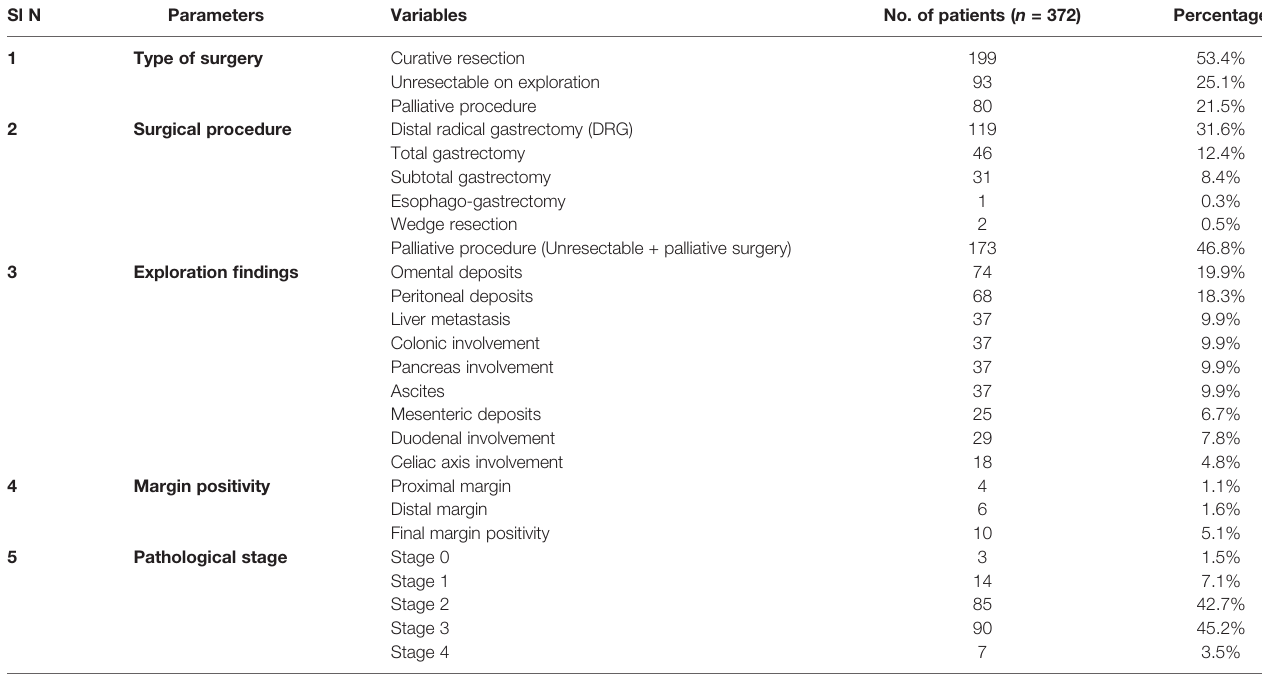
TABLE 2 | Surgical details and pathological